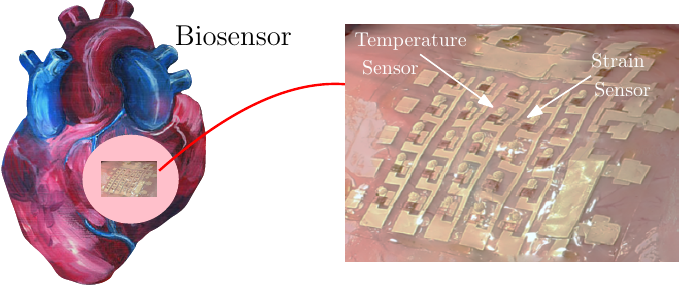
Figure 3. Schematic diagram of biosensor monitoring heart health